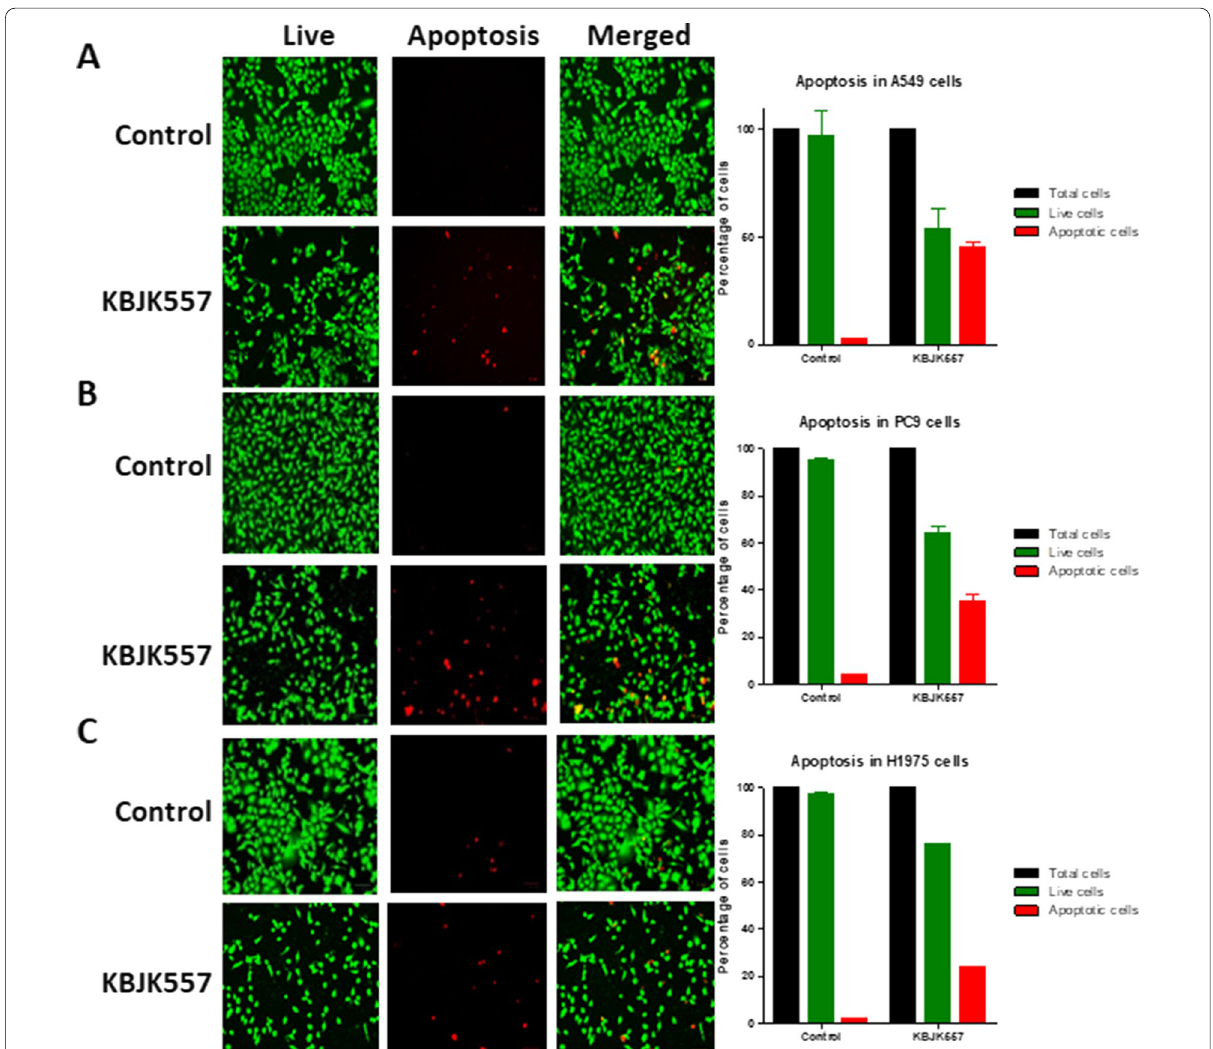
Fig. 3 Induction of apoptosis in non‑small cell lung cancer cells by KBJK557. Fluorescence microscopy images ( green fluorescence represents live cells and red fluorescence represents dead cells. A – C Apoptosis assays in A549 cells, PC9 cells, and H1975 cells,